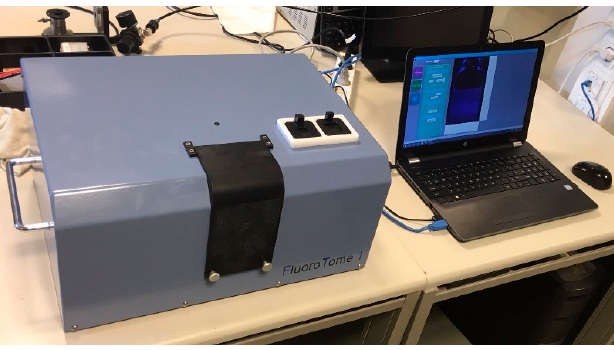
Figure 3. The complete FluoroTome 1 apparatus including laptop with software for camera and stage control and data management.